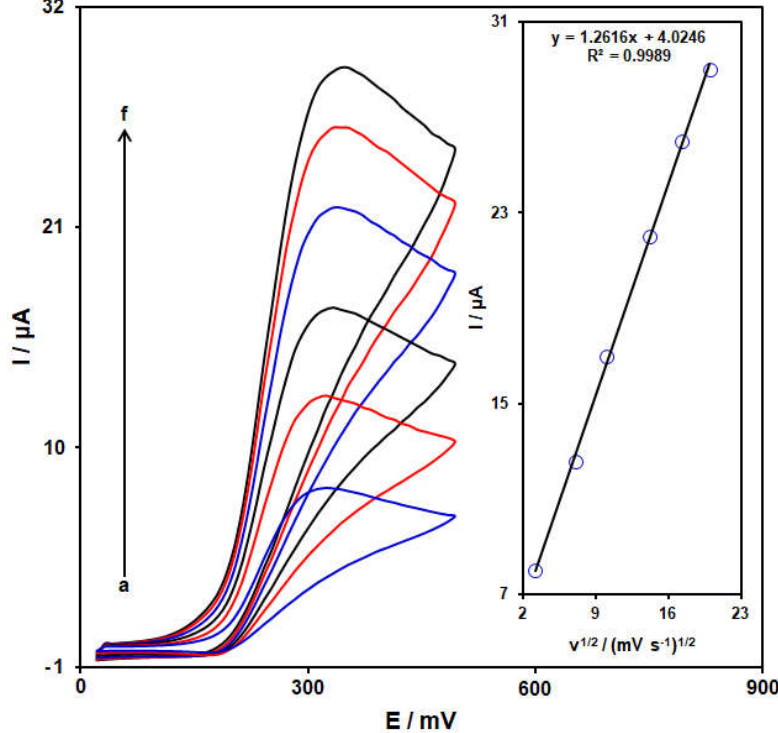
Figure 7. Cyclic voltammograms captured for epinine (100.0 µM) in PBS (pH 7.0, 0.1M) on Ni- Co-MOF/SPGE at variable scan rates; a−f correspond to (a) 10, (b) 50, (c) 100, (d) 200, (e) 300 and (f) 400 mV/s. Inset: Plot of Ipa against υ 1/2 for epinine electro−oxidation. (f) 400 mV/s. Inset: Plot of Ipa against υ 1/2 for epinine electro −